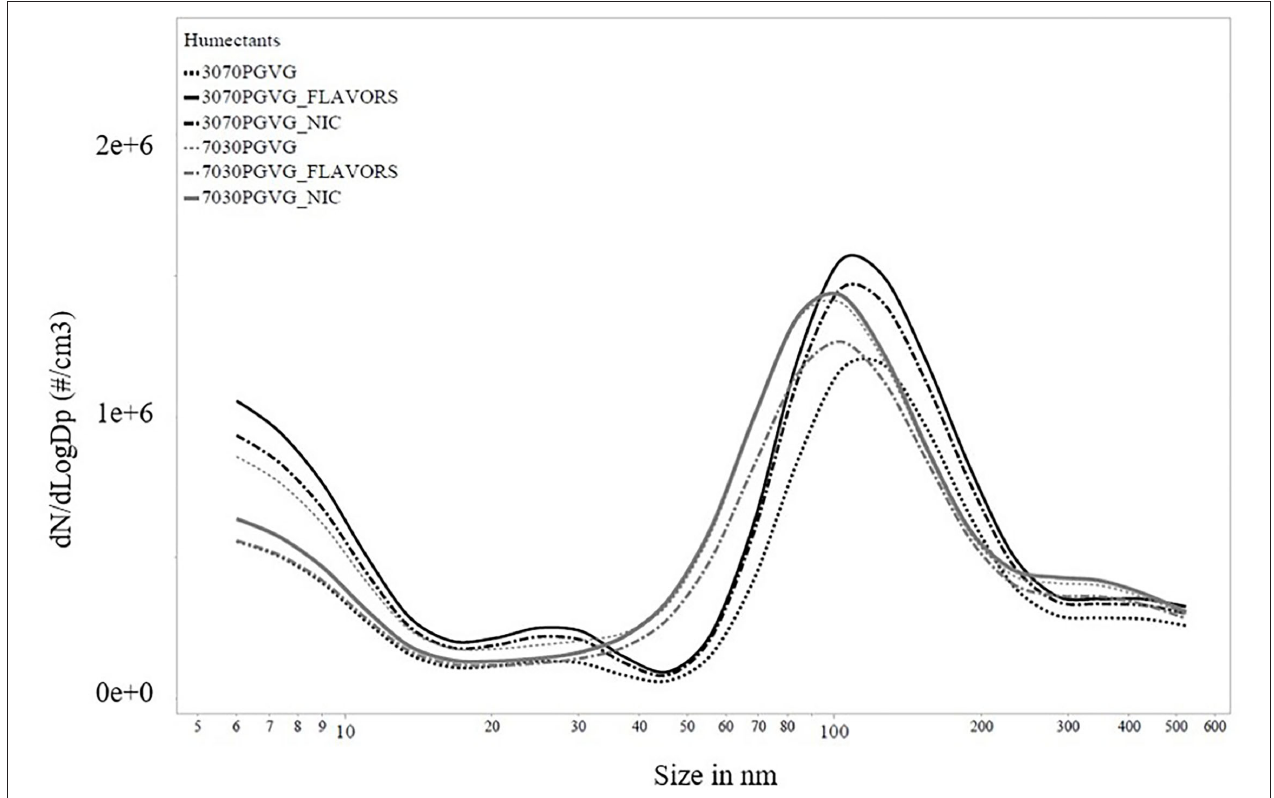
FIGURE 2 | Particle number concentration by size for fast mobility particle sizer (FMPS) measurements. PG, propylene glycol; VG, vegetable glycerin; Nic,